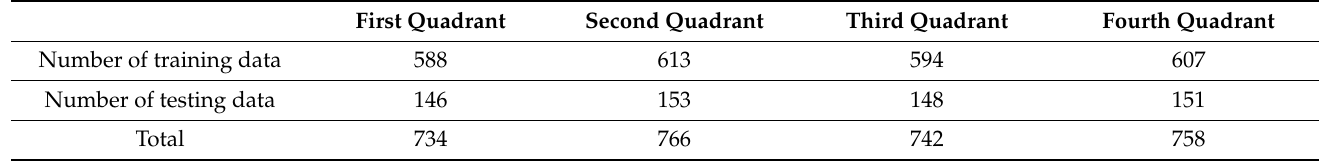
Table 1. Numbers of training data and testing data for first learning epoch.